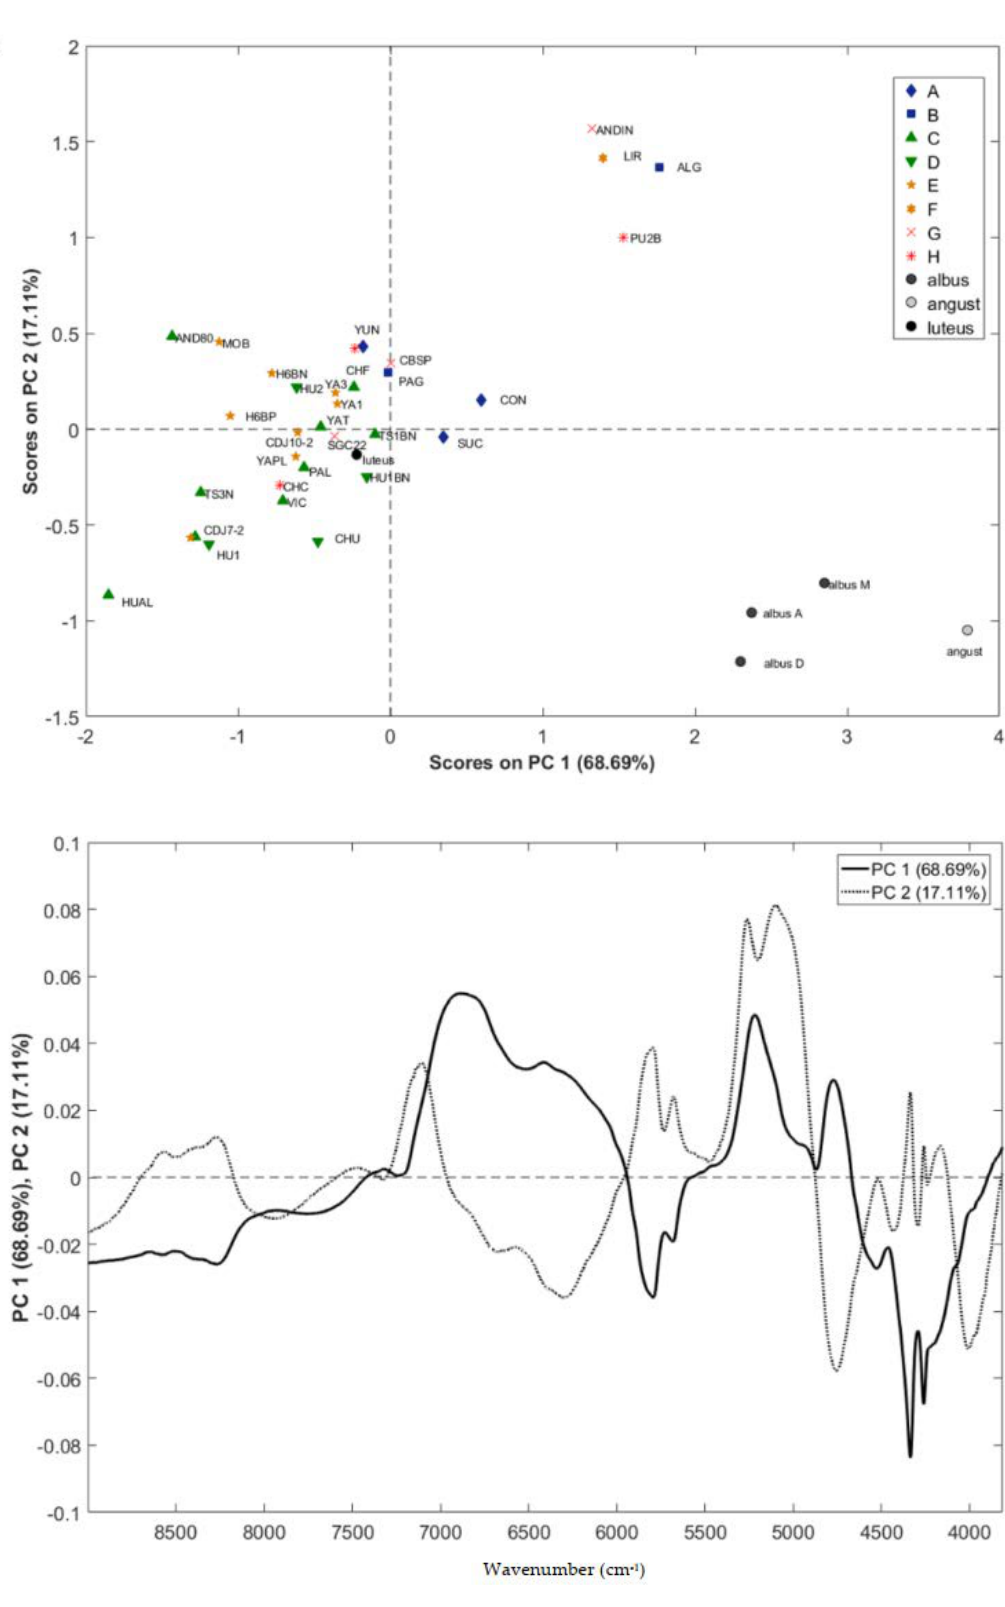
Figure 5. Principal component analysis performed on the FT-NIR spectra of debittered seeds of 33 L. mutabilis , three L. albus , one L. angustifolius and one L. luteus ; the ecotype codes are defined